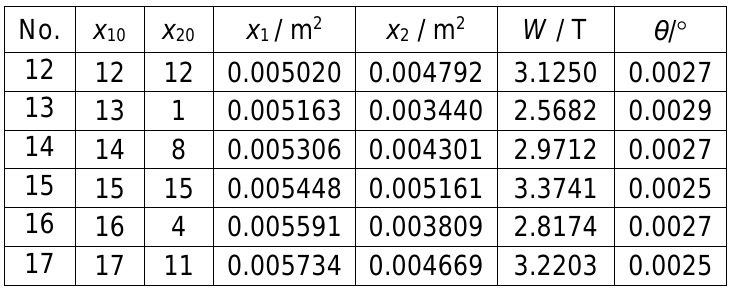
Table 2 – Evaluation results of this